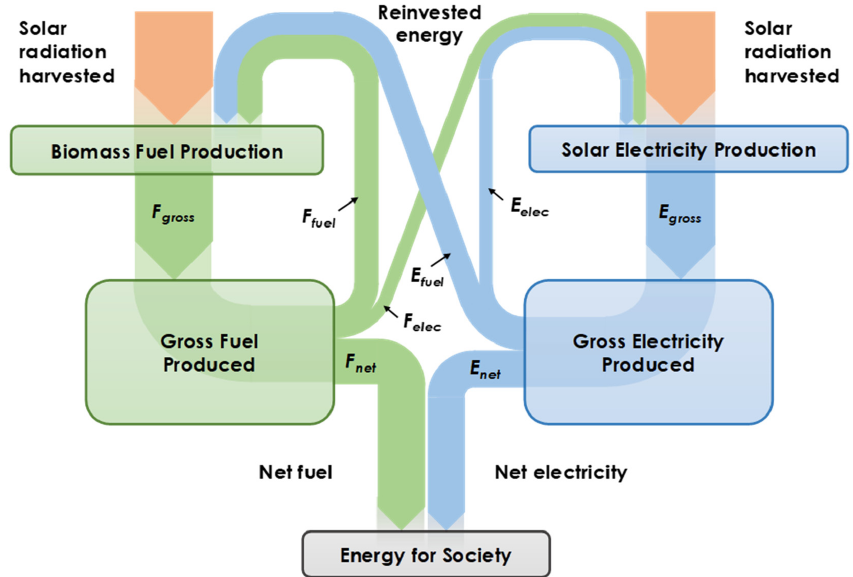
Figure 1. Conceptual model of simplified two-mode energy supply with electricity and bioenergy, including reinvestment of both forms of energy in each other. Arrow widths are indicative only (not to scale).